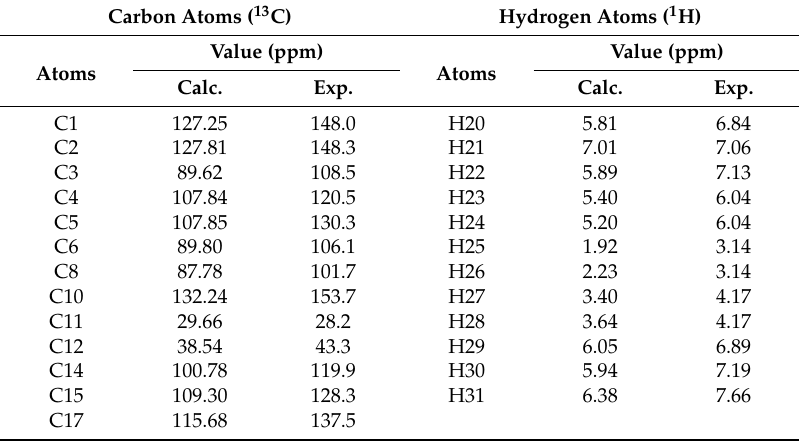
Table 5. Calculated and experimental chemical shift values for compound 4